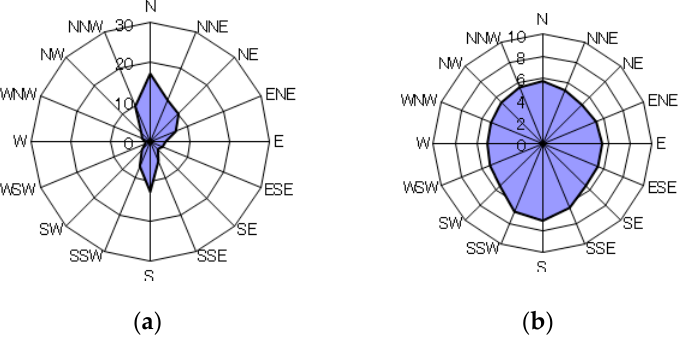
Figure 4. Characteristics of wind at Noma Wind Park, WT #4, for the year from June 2002–May 2003. ( a ) Occurrence frequency (%); ( b ) annual average wind speed (m/s).